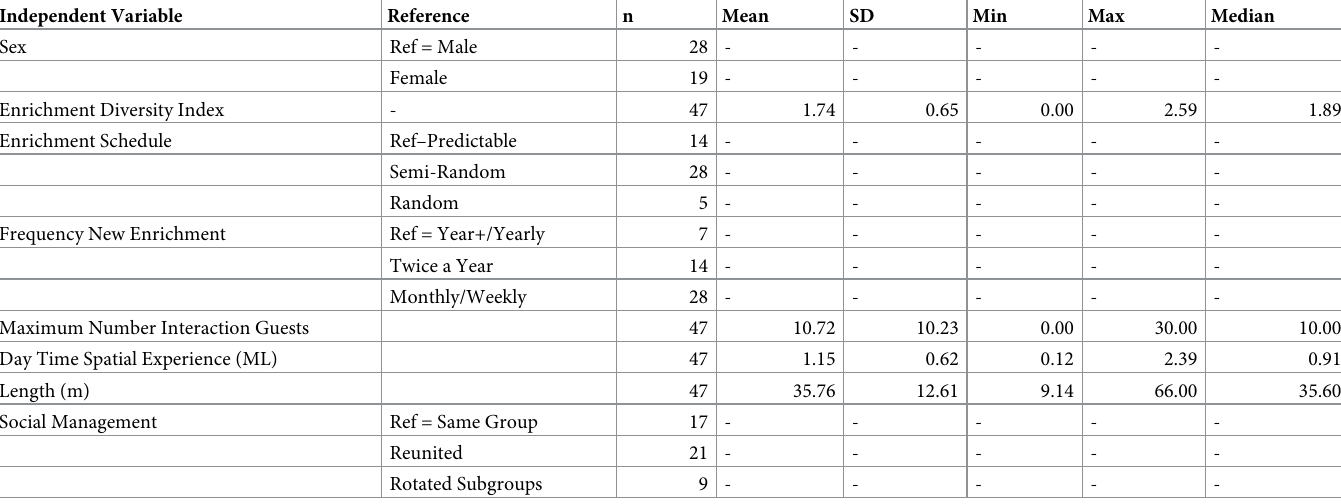
Table 7. Descriptive statistics for independent variables considered for multivariate model of interact with conspecific